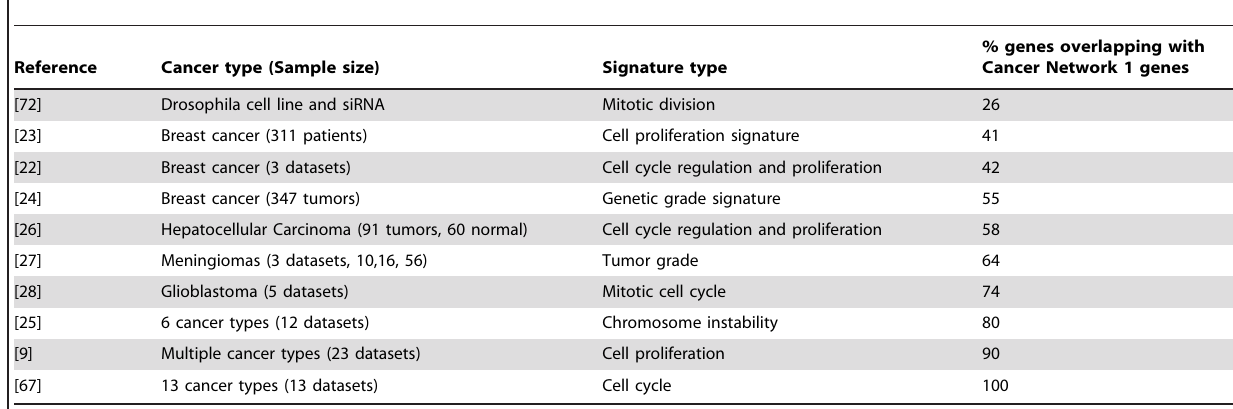
Table 3. Comparison of Cancer Network 1 with gene signatures from other cancer microarray